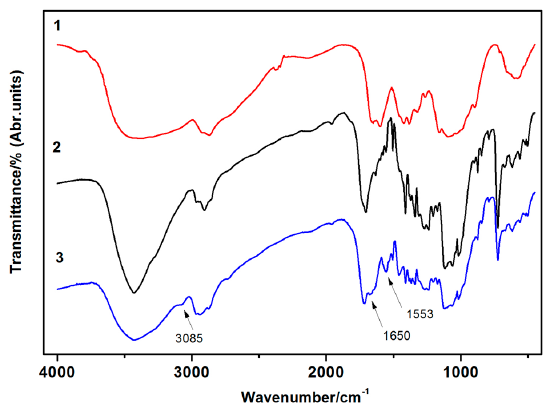
Figure 7. FT-IR spectrum of: ( 1 ) PNIPAAm/Cs hydrogel; ( 2 ) cotton fabric; and ( 3 ) cotton modified with the IPN hydrogel.